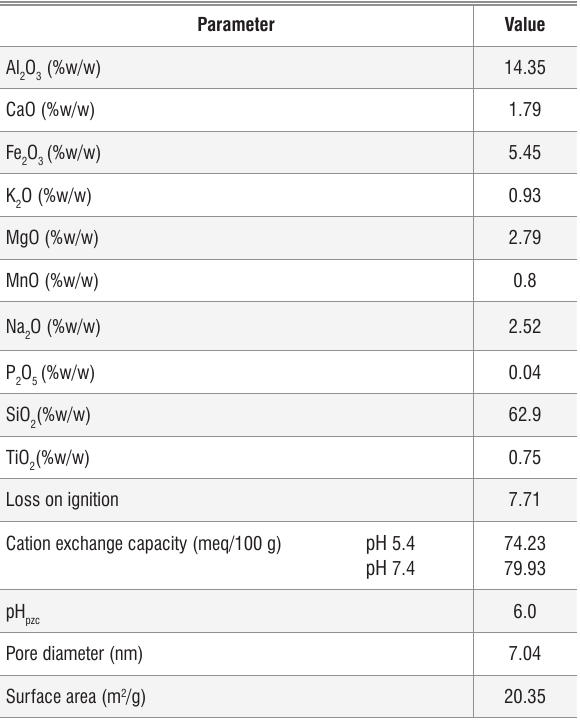
Table 1: Physicochemical properties of the smectite-rich clay soil Parameter